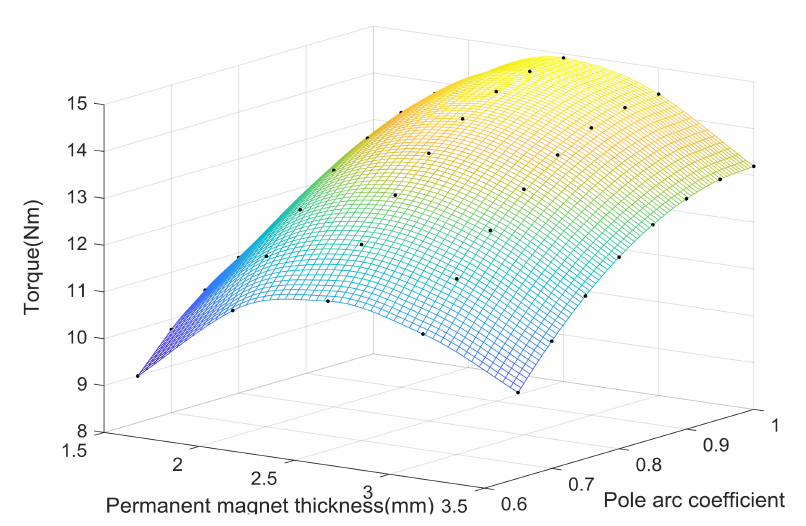
Figure 21. Response surface of sub objective T max .